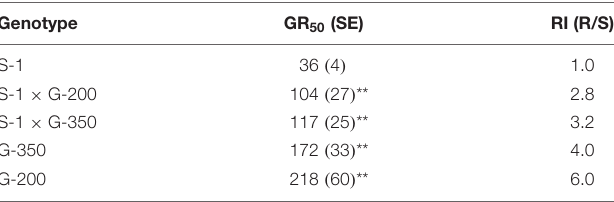
TABLE 3 | Regression parameters describing the response of sorghum genotypes and their F 1 progeny to tembotrione under greenhouse conditions. Genotype